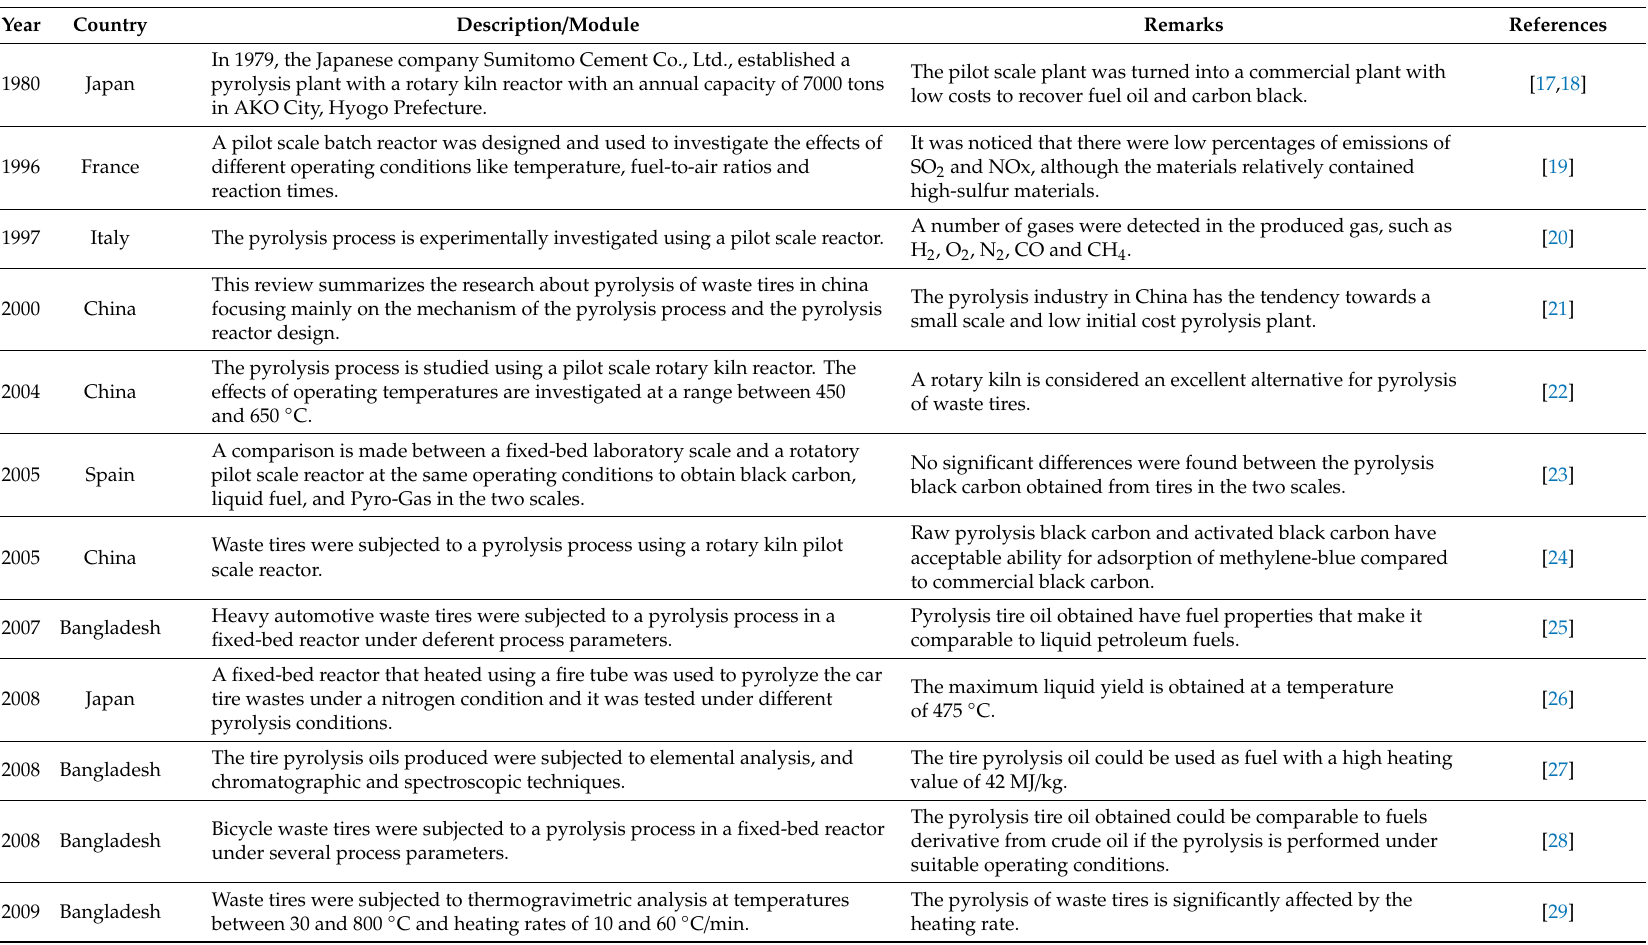
Table 1. Pyrolysis research for di ff erent countries worldwide: A representative list of waste tire pyrolysis